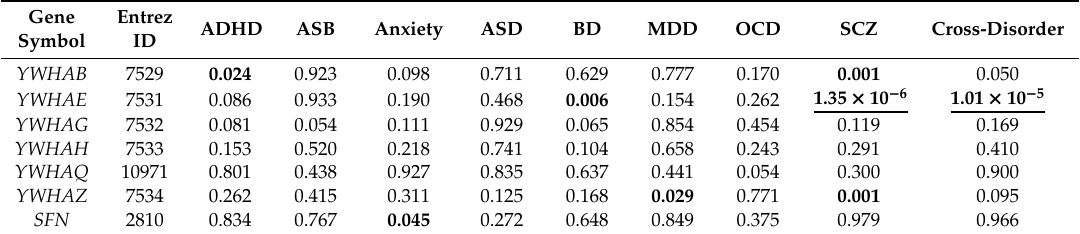
Gene-based association analysis of each of the seven 14-3-3 genes across several psychiatric